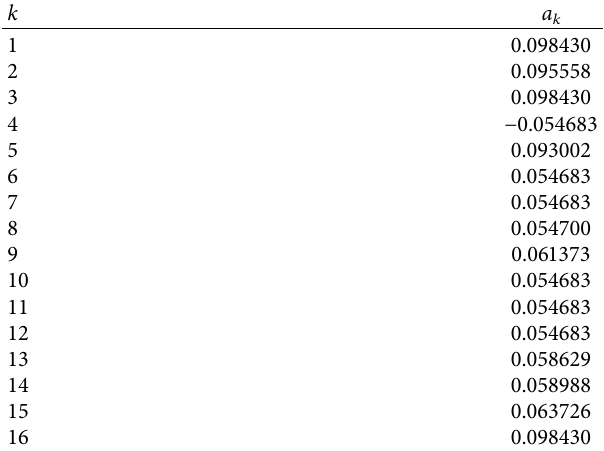
Table 4: Optimum coefcients of proposed array from Table 2.